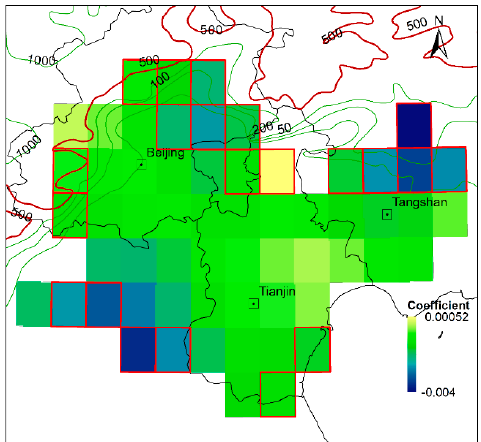
Figure 7. The distribution of the estimated regression coefficient of urbanization index (UBRI). Squares outlined in red represent the “wet island effects” dominated area. outlined in red represent the “wet island e ff ects” dominated